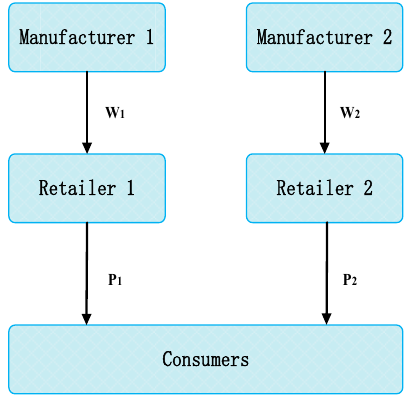
Figure 1. Structure of the manufacturing supply chain under duopoly model.